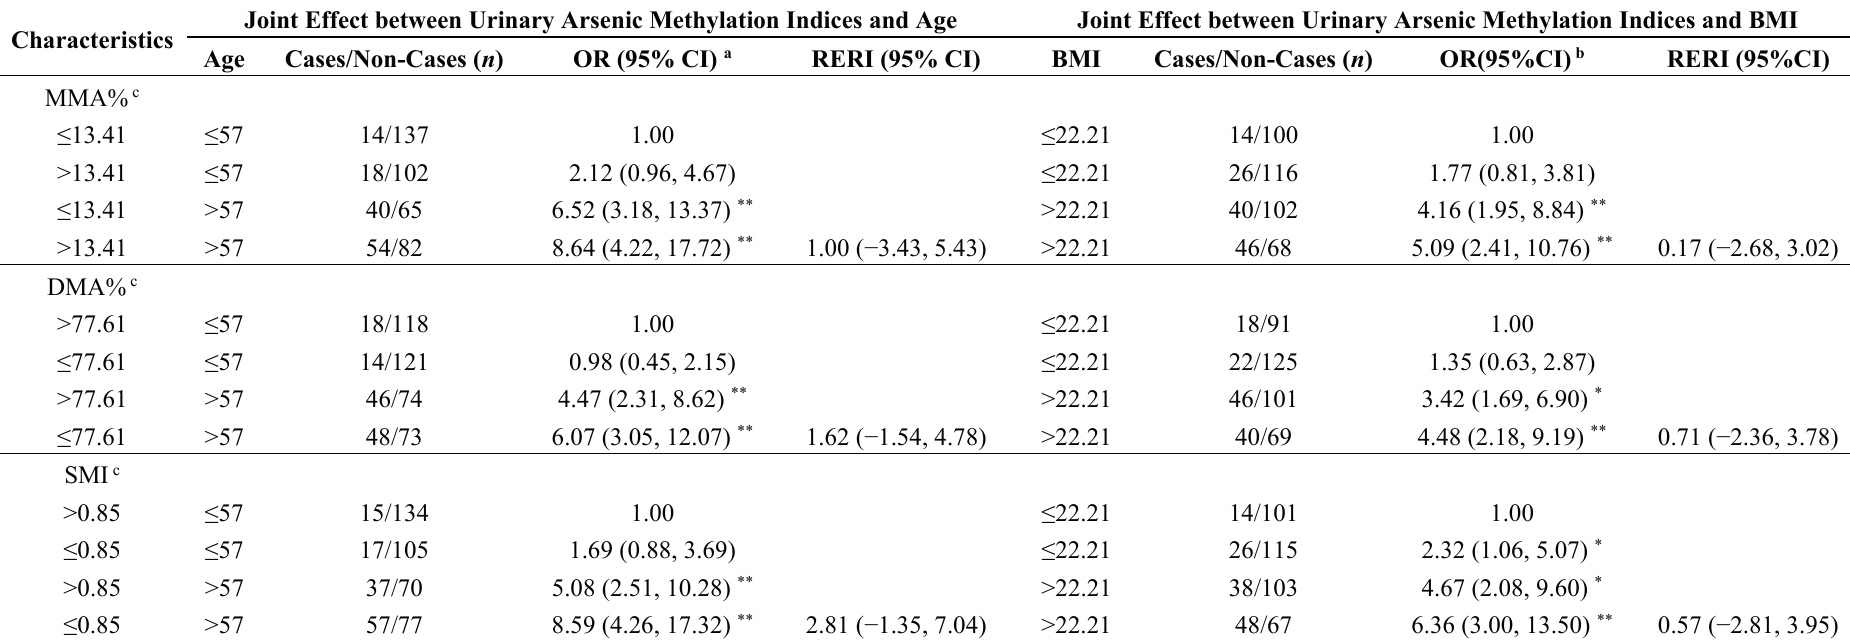
Table 3. The joint effects of urinary arsenic methylation indices with age and BMI on hypertension risk among subjects from arsenic-endemic area in Inner Mongolia, China ( n =